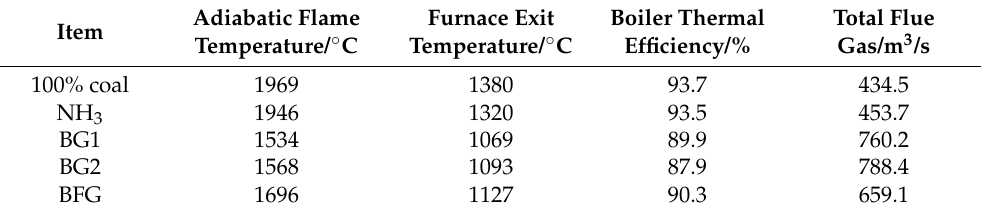
Table 4. Some performance parameters of co-firing different gaseous fuels at the ratio of